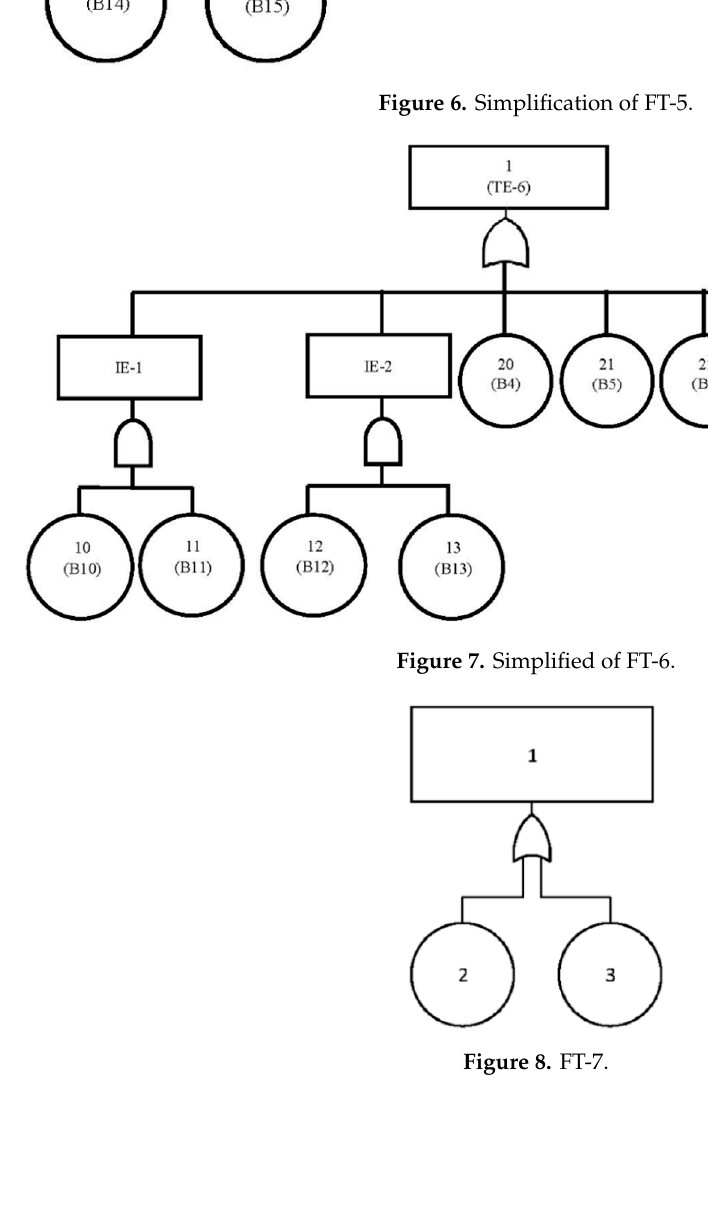
Figure 9. Simplification of FT-8. 3.5. Risk Analysis by ETA